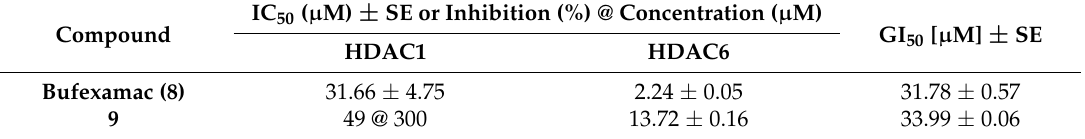
Figure 5. Detection of acetylation levels of H3 and tubulin after incubation of HL60 cells with bufexamac and the carbamate 9. GAPDH was used as a loading control.